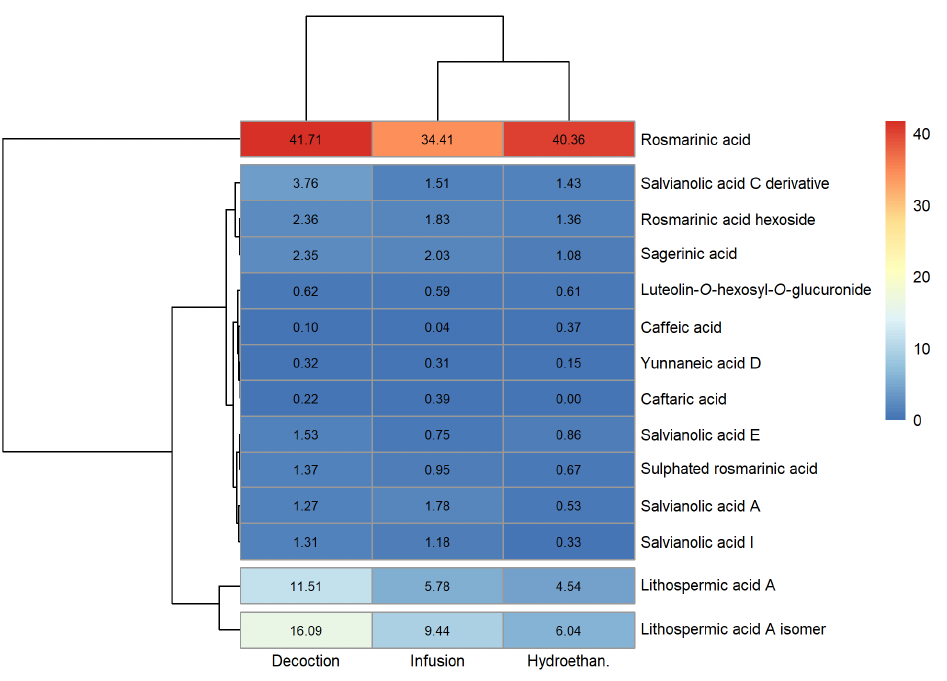
Figure 2. Clustered heatmap visualisation of phenolic compounds detected in lemon balm infusion, decoction and hydroethanolic extract (units: